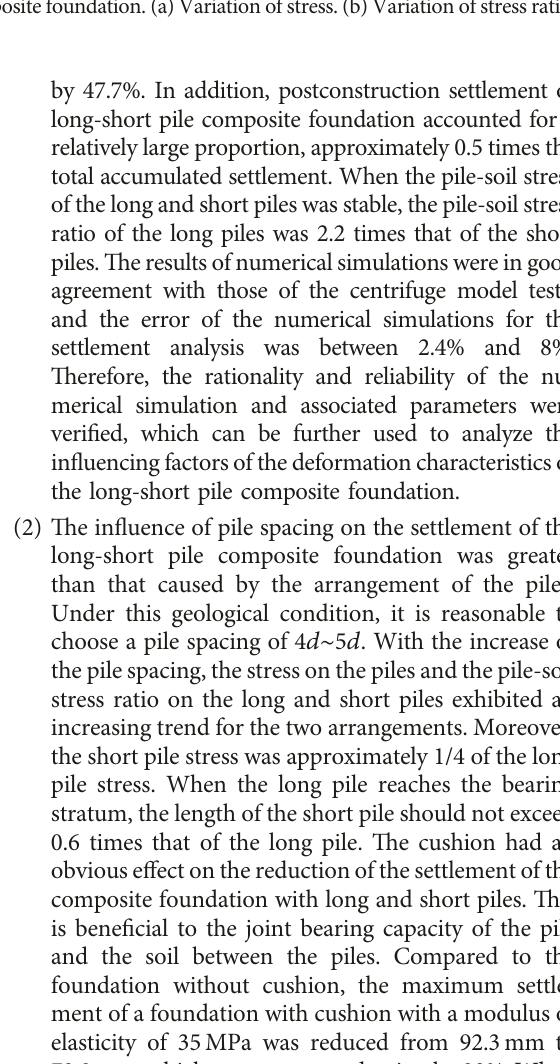
Figure 17: Effect of cushion on bearing characteristics of long-short pile composite foundation. (a) Variation of stress. (b) Variation of stress